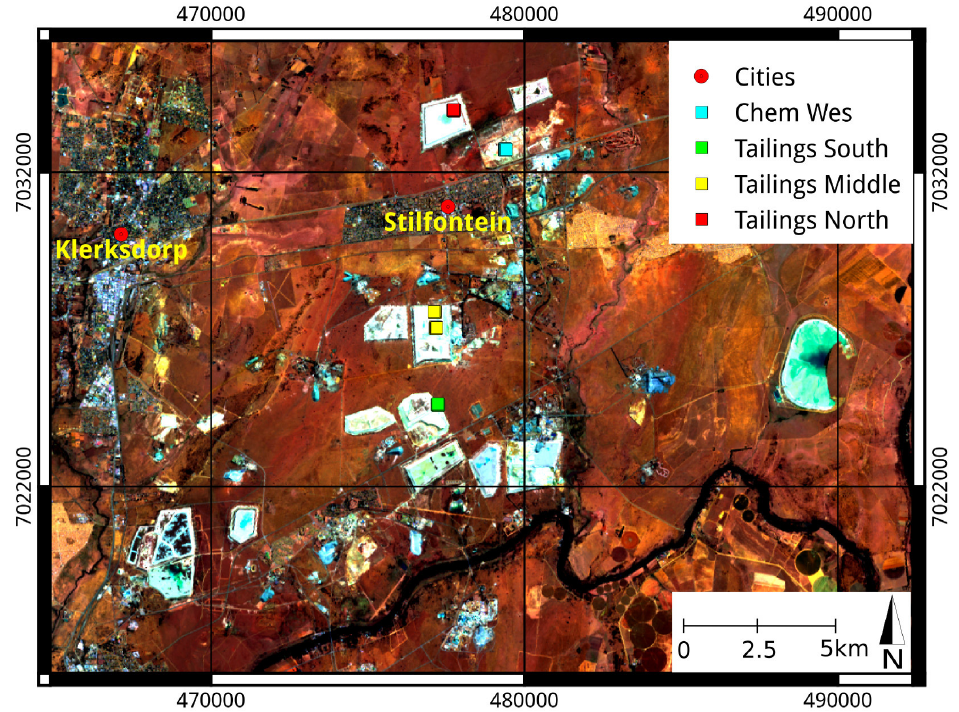
Figure 3. Landsat 8 composite (R: 2200 nm, G: 655 nm, B: 482 nm) showing the tailings facilities and test sites (colored stars) visited in the field area around